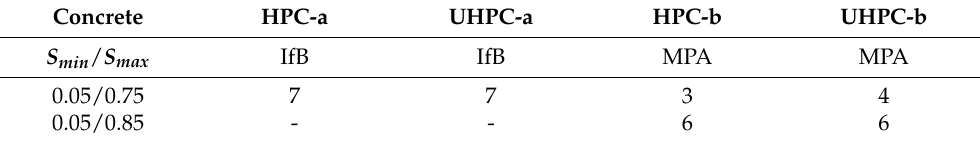
Table 3. Number of fatigue tests